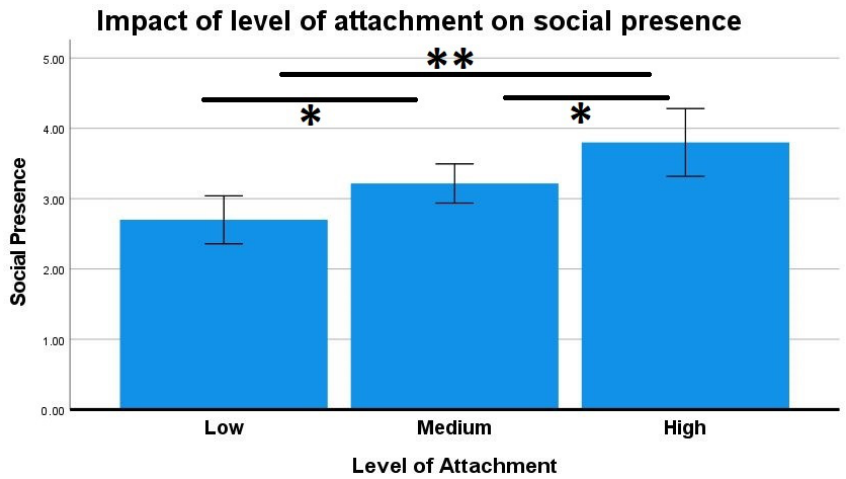
Figure 3. * p < 0.05, ** p < 0.01; Participants’ perception of the robot as a social entity from not at all (1) to very much (5), based on their level of attachment to the robot (low, medium,